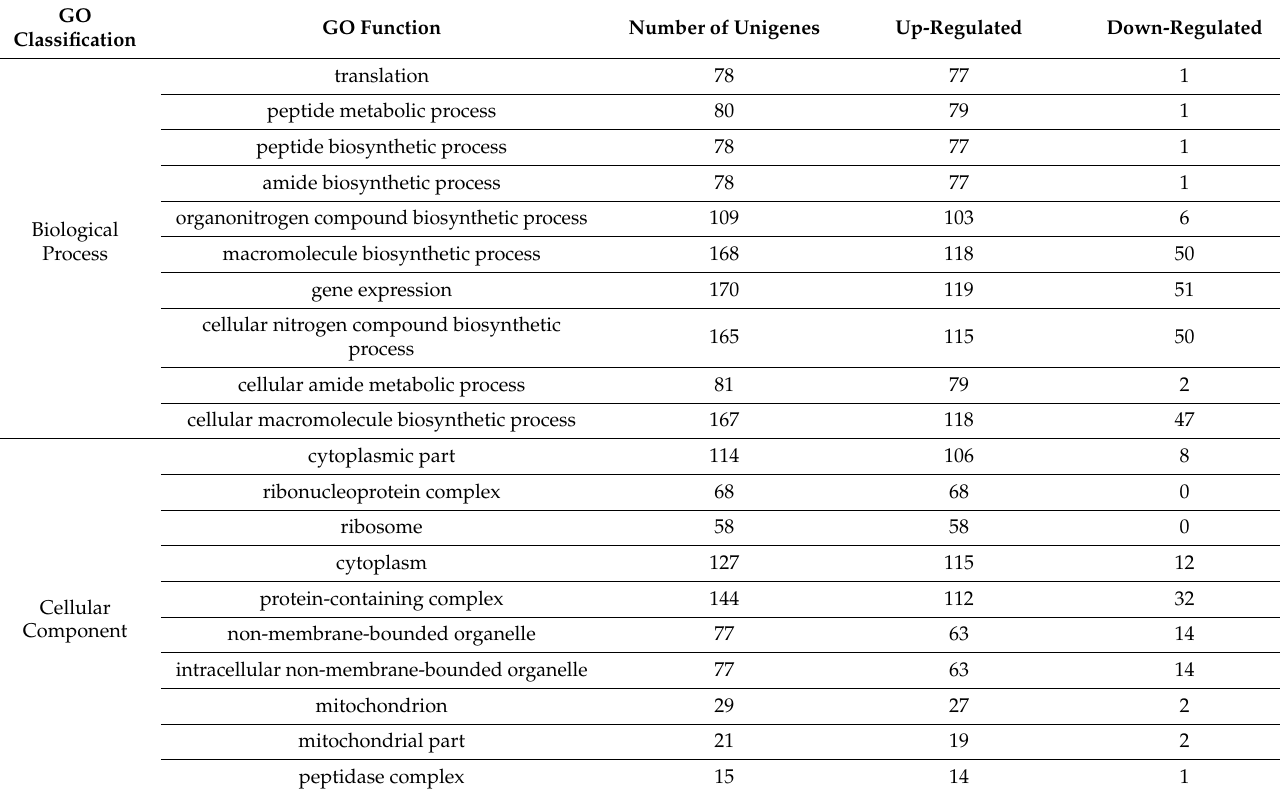
Table 3. GO function classification of differentially expressed